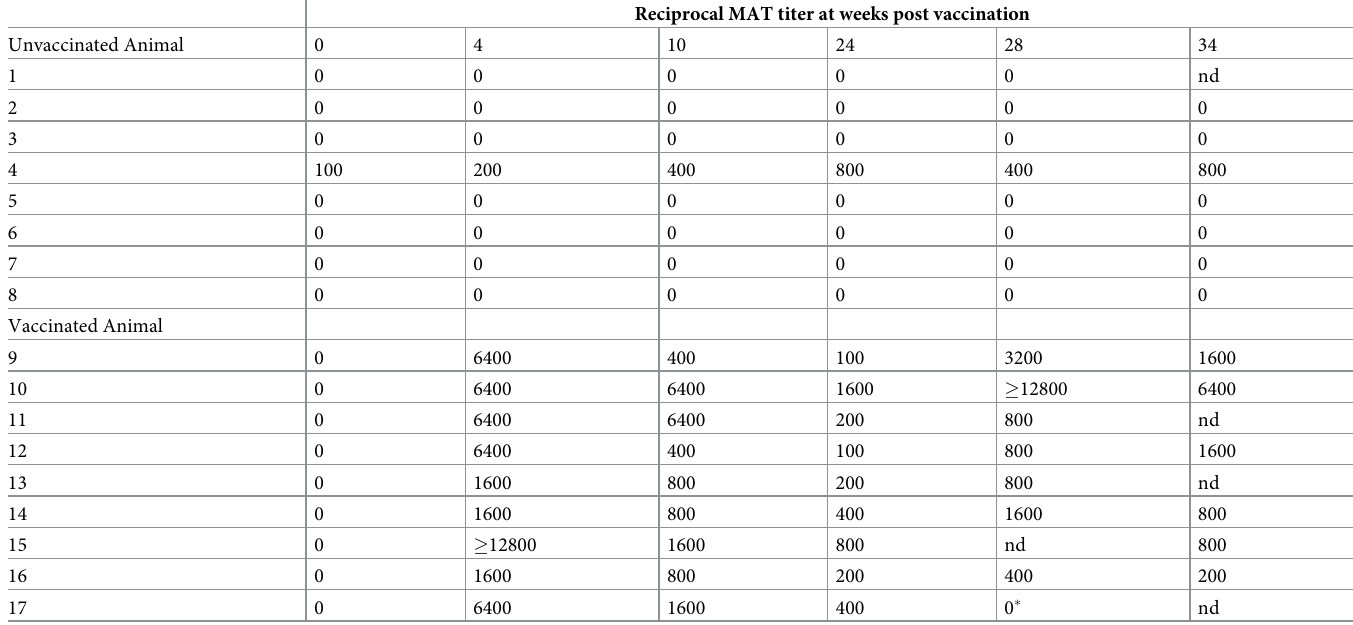
Table 3. Individual animal MAT titers for Leptospira Icterohemorrhagiae across 34 weeks post initial